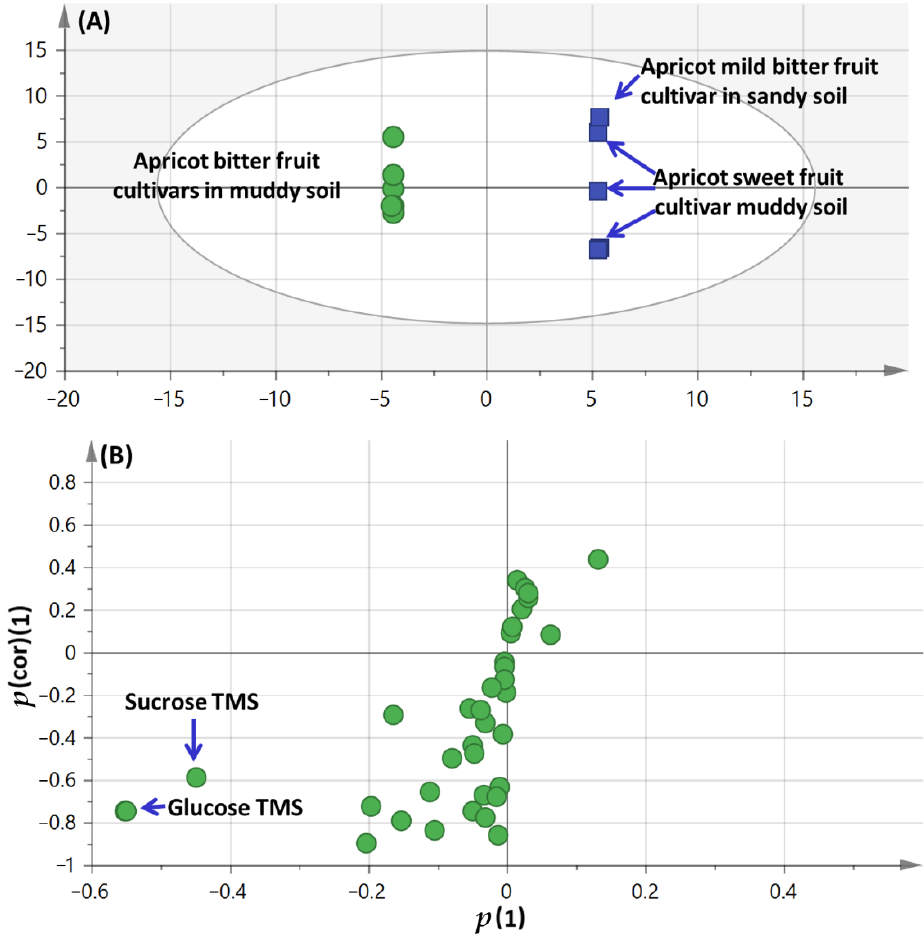
Figure 3. GC–MS-based OPLS-DA score plot ( A ) derived from modeling silylated primary metabolites of apricot fruit cultivar grown in sandy versus muddy soil ( n = 3). The respective loading S-plots ( B ) showing the covariance p (1) against the correlation p (cor) (1) of the variables of the discriminating component of the OPLS-DA model. Cut-off values of p = 0.32 was used. Designated variables are highlighted and identifications are discussed in the text.